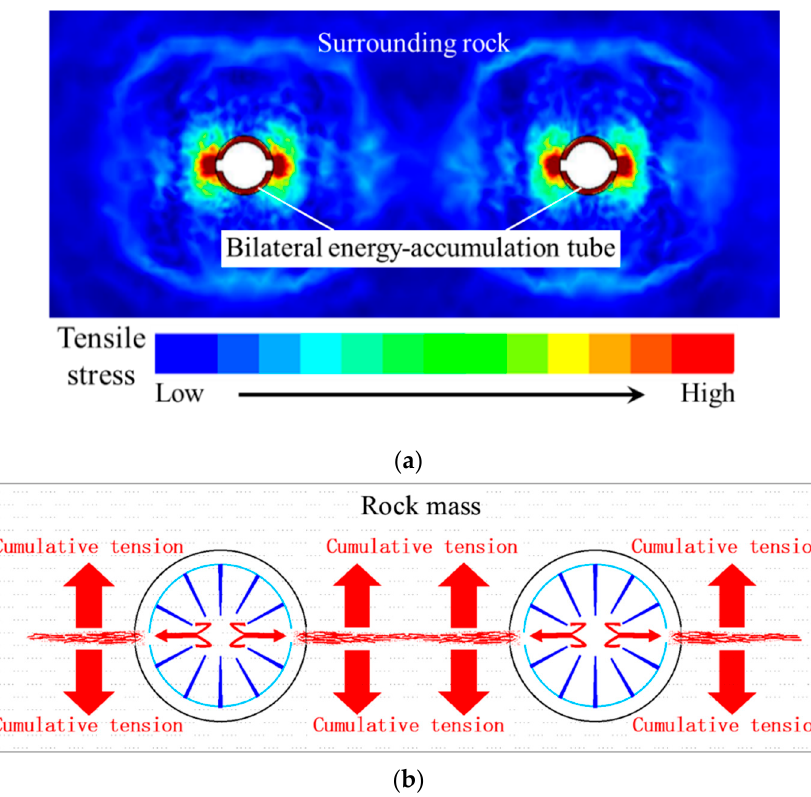
Figure 3. Directional tensile blasting principle. ( a ) Blasting stress field; ( b ) mechanical model.